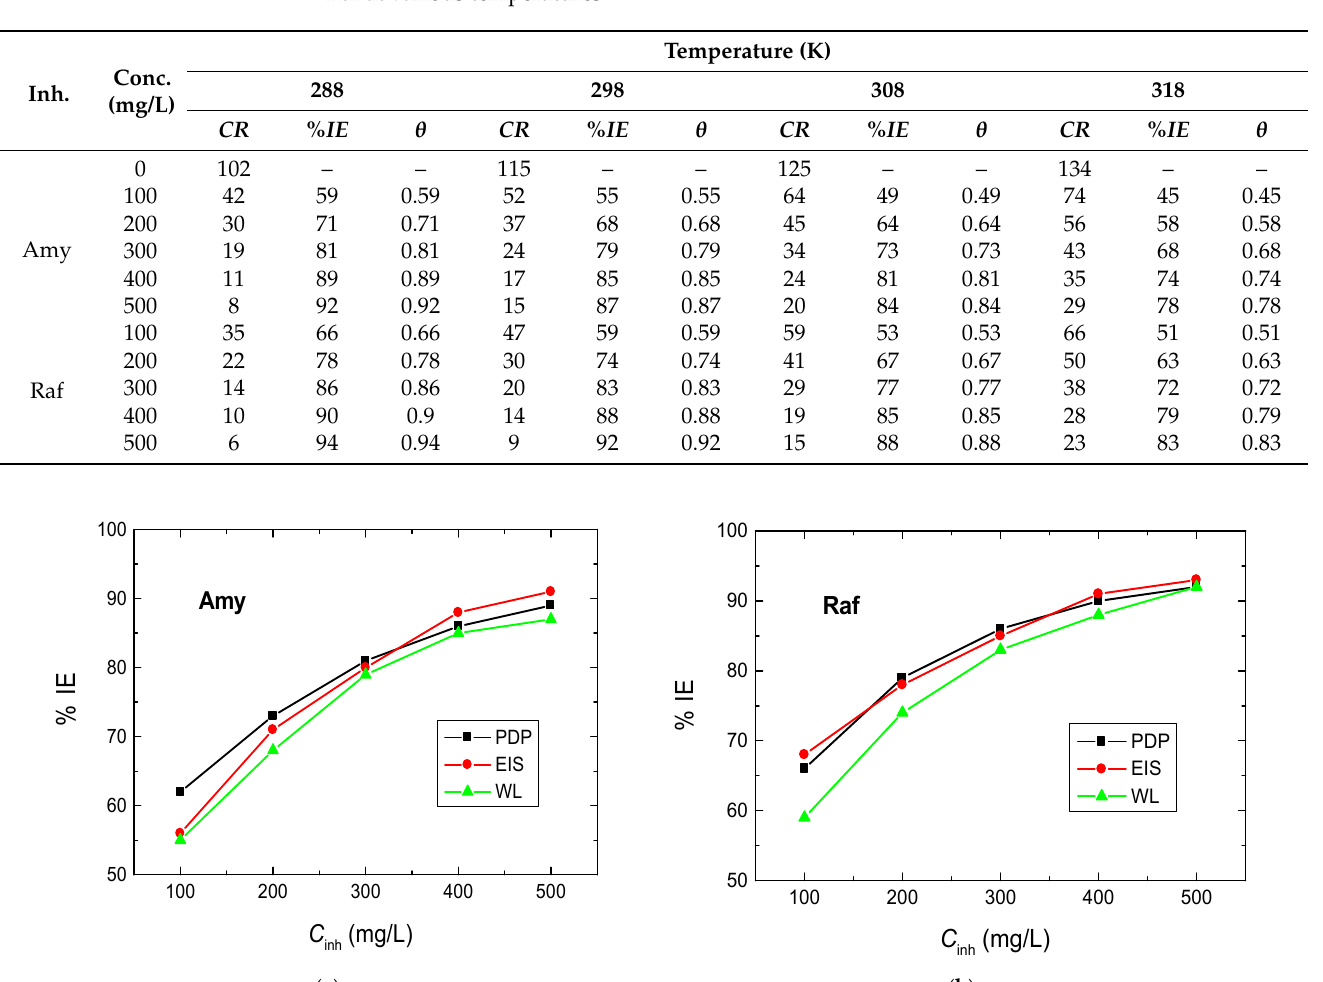
Table 4. The mean values of corrosion rates ( CR s) of Al in 0.1 M NaOH medium and with Amy and Raf at various temperatures.